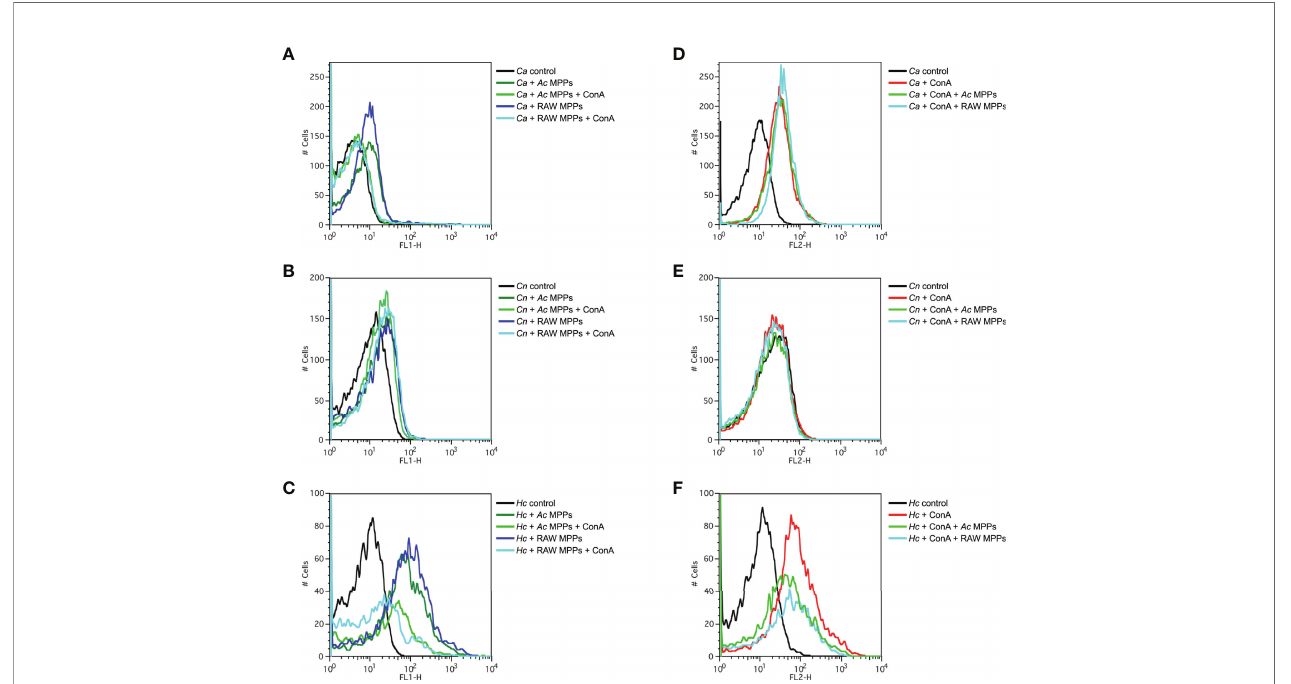
FIGURE 4 | Mannose-puri fi ed proteins (MPPs) of Acanthamoeba castellanii and macrophages recognized targets on the fungal cell wall. (A – C) Histograms representing the FL1-H fl uorescence and binding intensity of phagocytes MPPs to fungi (A) Candida albicans ( Ca ), (B) Cryptococcus neoformans ( Cn ) and (C) Histoplasma capsulatum ( Hc ), with the respective co-incubation with Concanavalin A (ConA) for inhibition evaluations. (D – F) Besides, yeast labeling with the positive control ConA data on (D) Ca , (E) Cn and (F) Hc , which were analyzed by FL2-H intensity, are demonstrated, along with respective incubations with the MPPs of each phagocyte for inhibition